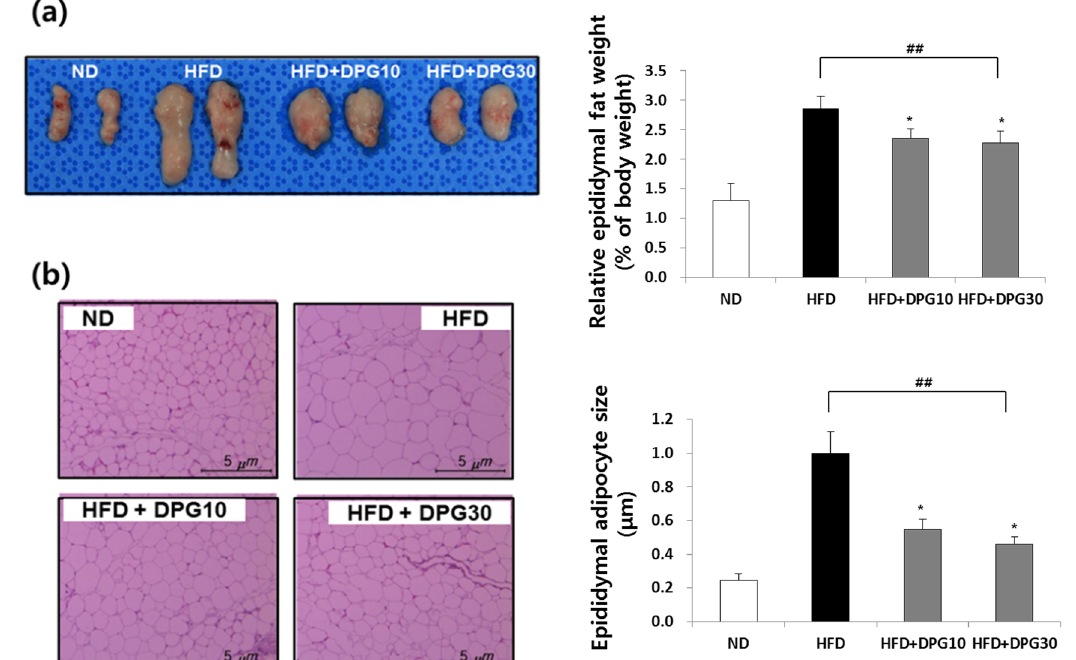
Figure 3. Effect of DPG10 and DPG30 on weight and size of adipocyte tissues in HFD ‐ induced obese mice. ( a ) Epididymal adipose tissue; ( b ) sections of epididymal adipose tissue stained with